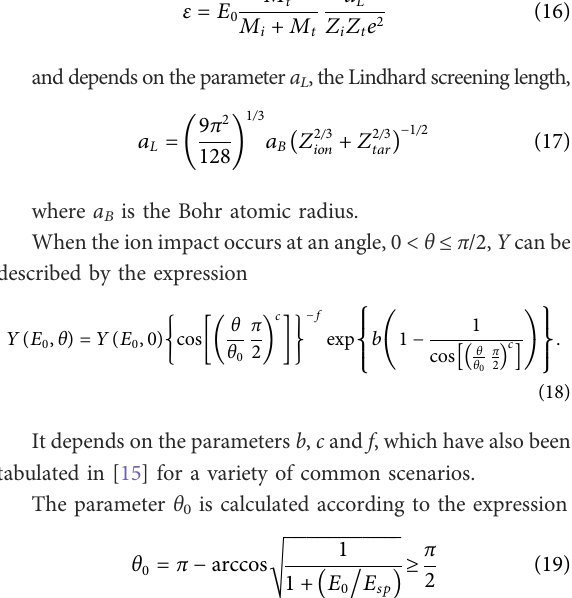
FIGURE 2 Comparison between the estimations provided by the helicon wave dispersion relation of Eq. 1 and experimental data published by Chen ([16]), [17] and [18]. The shaded regions correspond to variations in the estimation of n e when considering the uncertainty in the estimation of λ , taken as ±